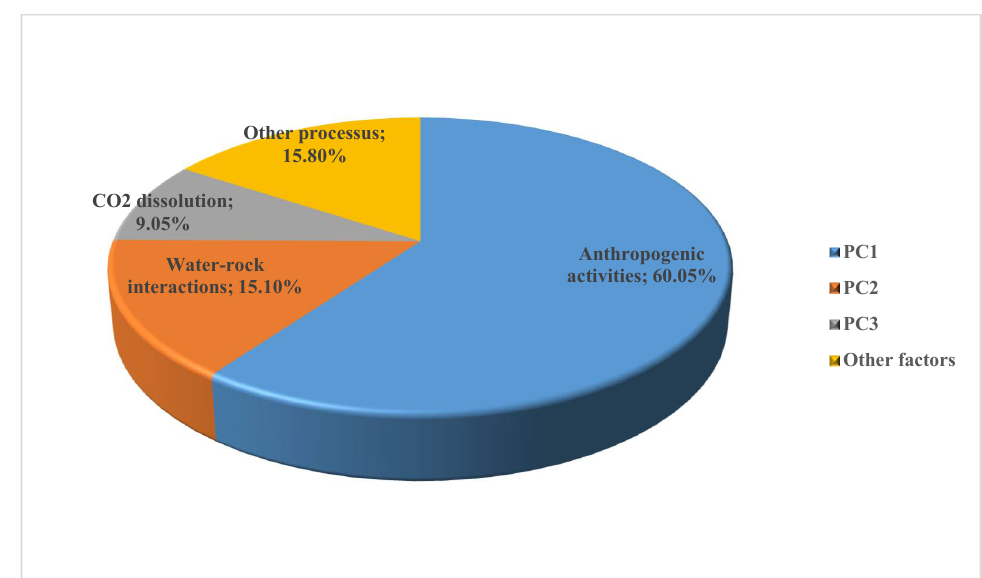
Figure 9. Aquifer chemistry control process.